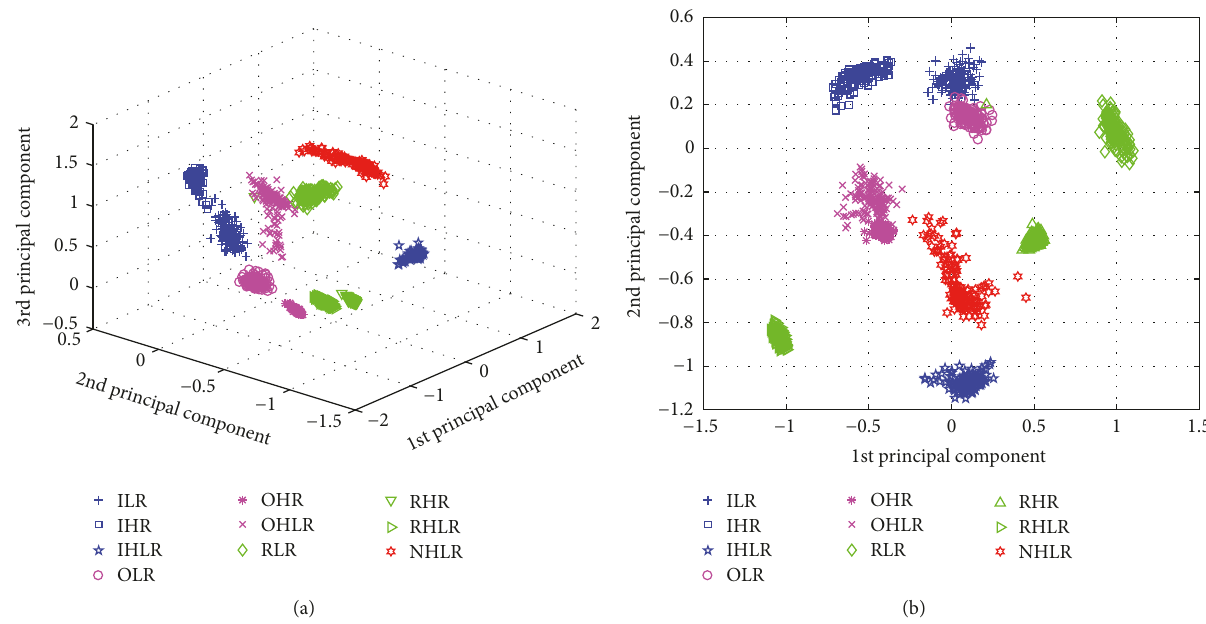
Figure 13: Feature visualization maps of standard SAE in Experiment 2. (a) The first three PCs; (b) the first two PCs.